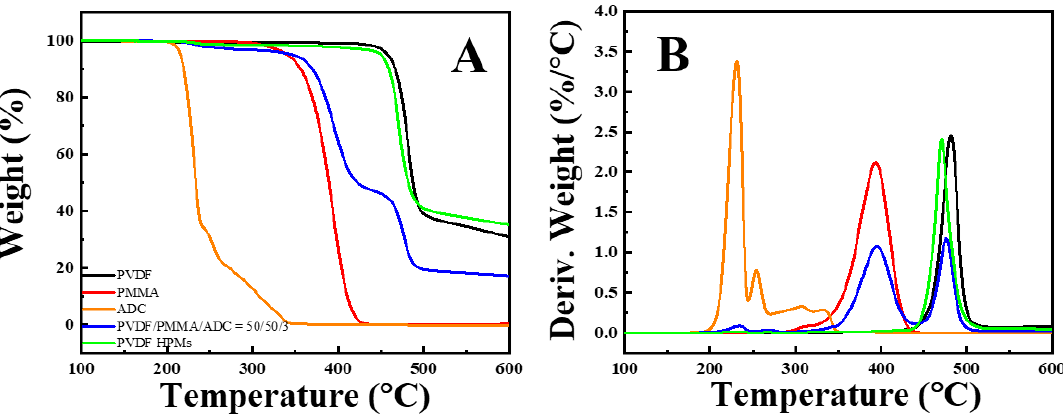
Figure 4. TGA ( A ) and DTG curves ( B ) of PVDF, PMMA, ADC, PVDF/PMMA/ADC (50/50/3) blends and PVDF HPMs.